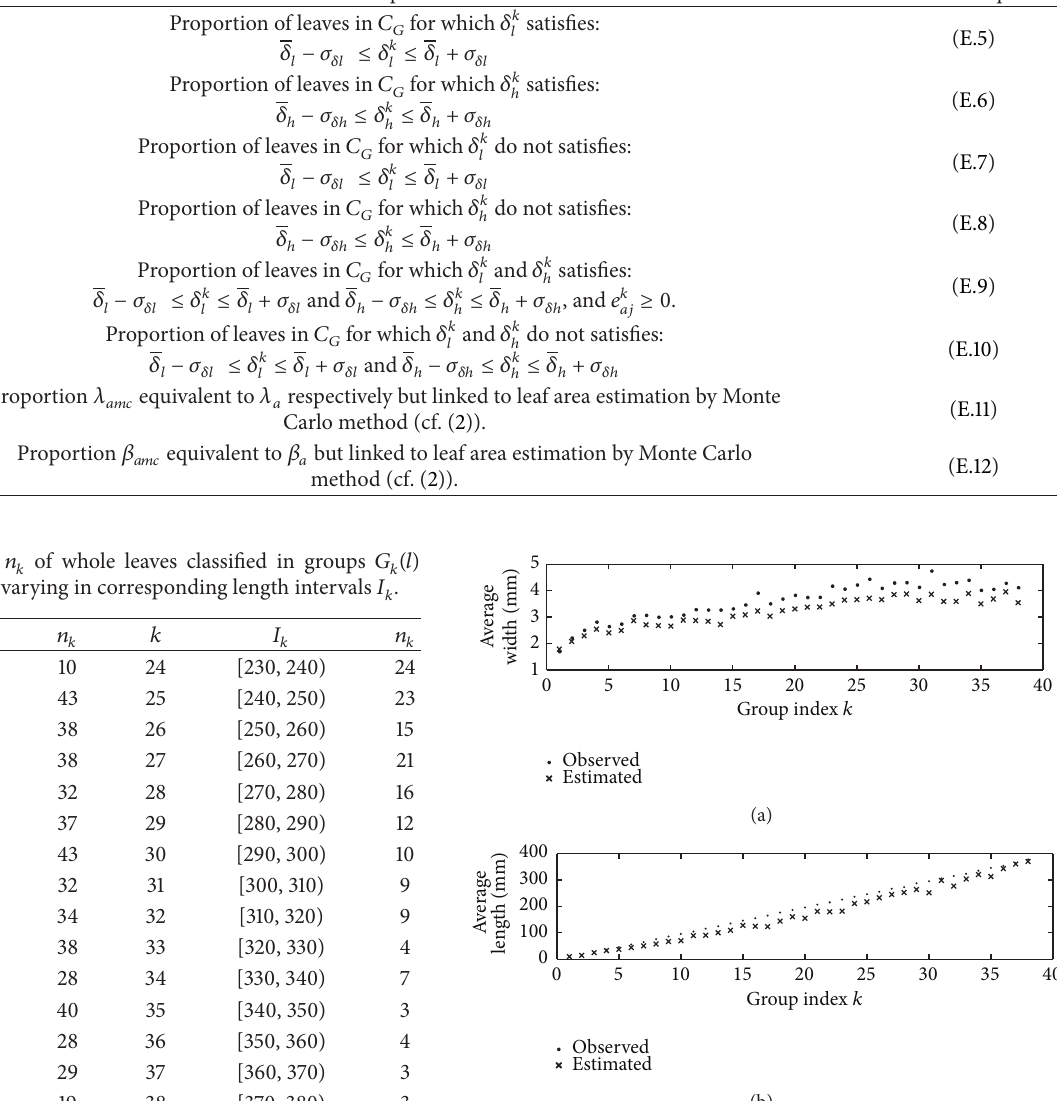
𝑘 𝑜 and image estimated 𝐺 (𝑙) . (b) Comparison of 𝑘 𝑙 𝑘 𝑑 length averages taken over